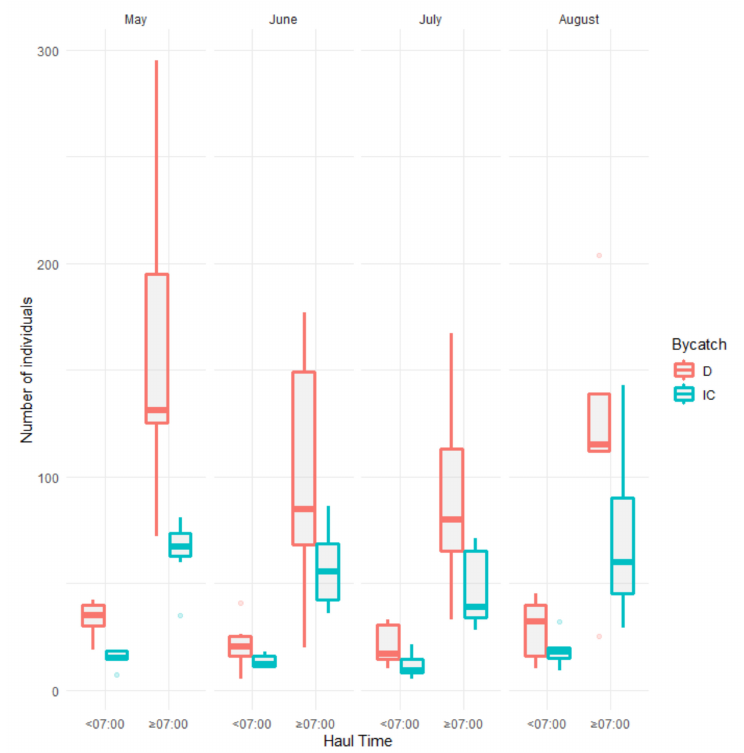
Figure 7. Number of individuals caught as incidental catch (IC) and discarded (D) before and after 07:00 a.m. during the main fishery period (1 May to 31